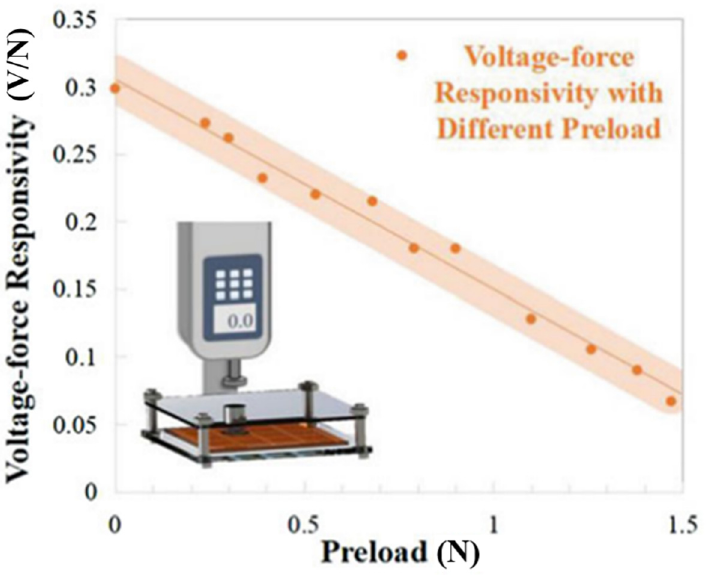
Figure 10. The unstable voltage-force responsivity with different preload [42].